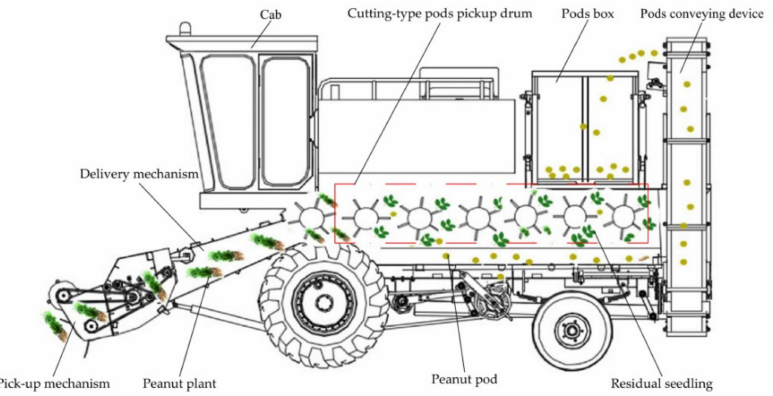
Figure 1. Working principle of a tangential-flow pickup